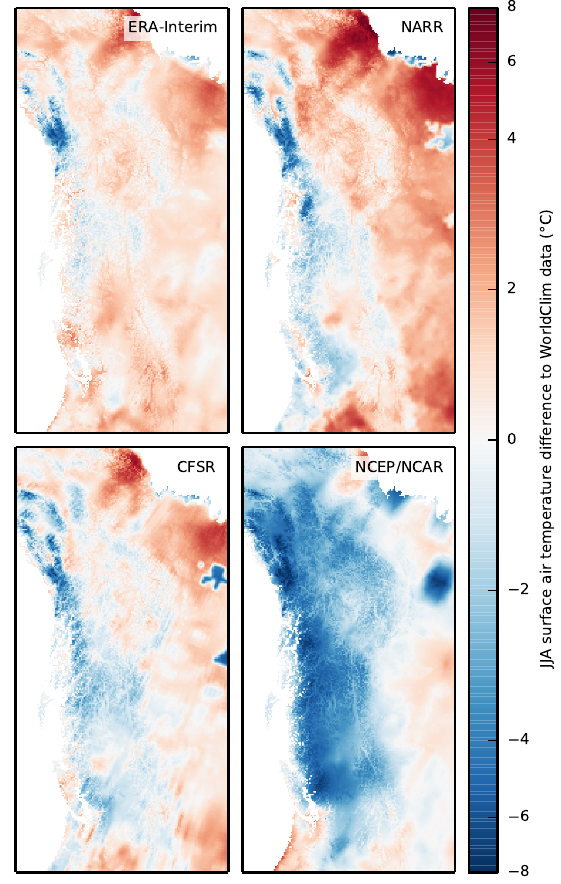
Figure 9. Summer (JJA) surface air temperature difference maps against WorldClim data, after bilinear spatial interpolation and lapse-rate correction. Note the cold bias of NCEP/NCAR data and temperature anomalies due to unresolved topographic